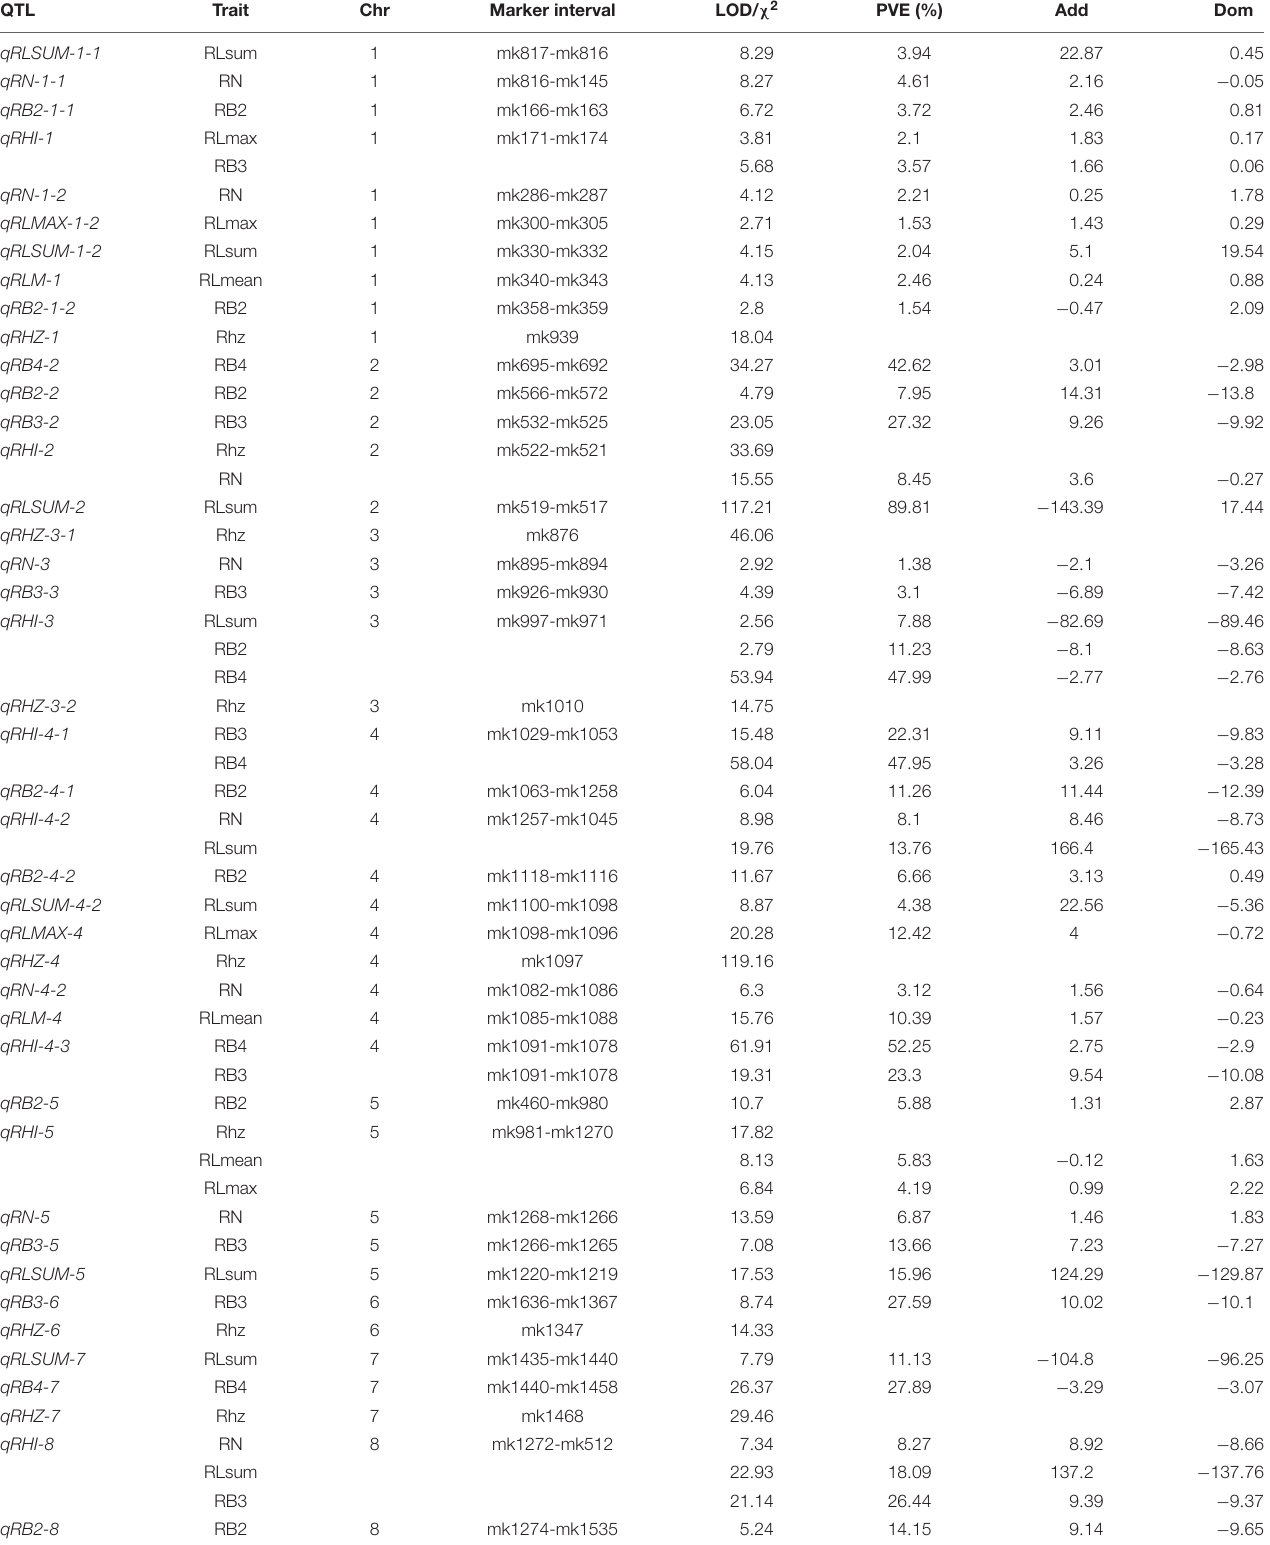
TABLE 2 | Loci affecting rhizome-related traits in the F 2